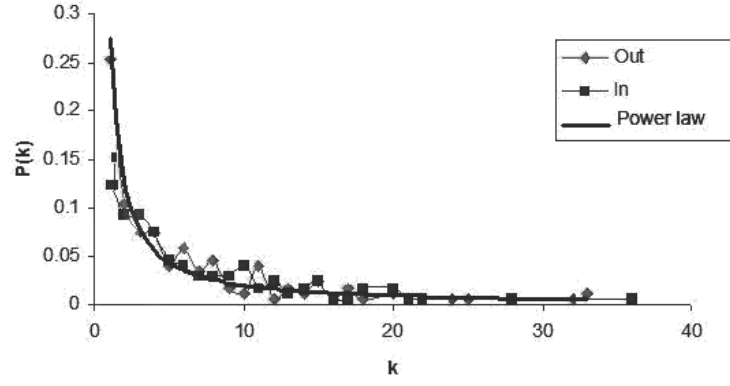
Figure 6 – Degree distribution of University degree courses